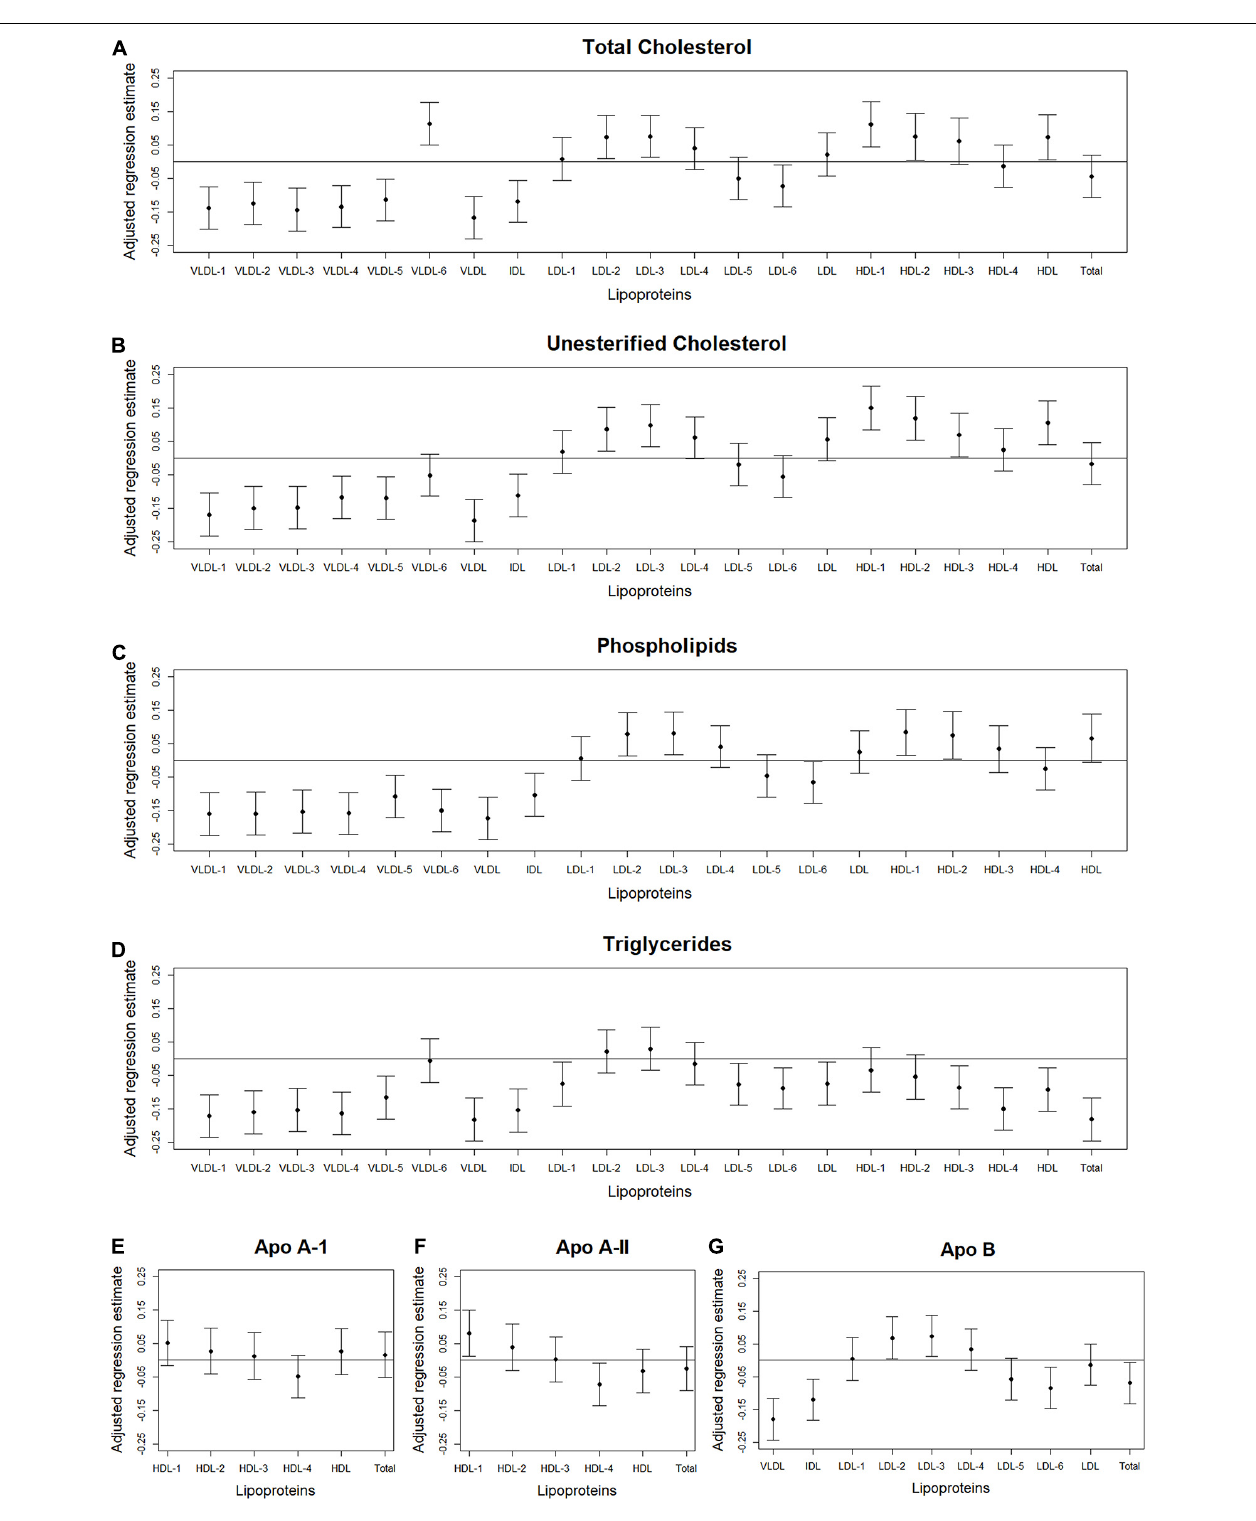
FIGURE 4 | Total abdominal IMAT density: Scatterplots of the adjusted associations between 105 lipoprotein subfractions and IMAT density ordered from lowest to highest density lipoprotein subfraction and by total cholesterol (A) , unesterified cholesterol (B) , phospholipids (C) , triglycerides (D) , apo A-I (E) , apo A-II (F) , and apo B (G) among 947 MESA